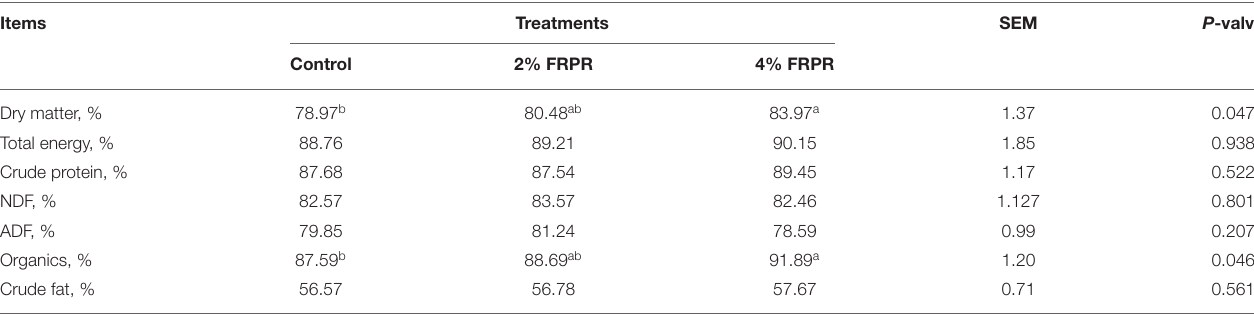
TABLE 3 | Effects of dietary supplementation with FRPR on nutrients digestibility of sows 1